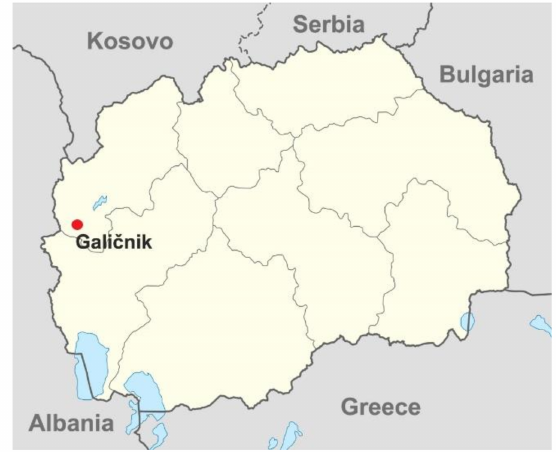
Figure 1. Geographic location of Galiˇcnik village in the Republic of North Macedonia. The map was modified from https: // en.wikipedia.org / wiki /